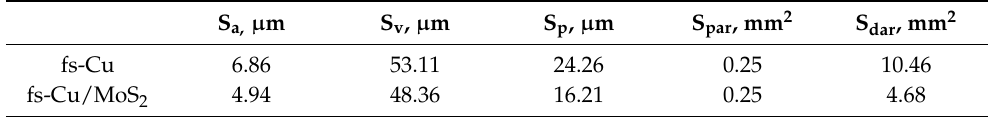
Table 1. The parameters calculated from the profilometric